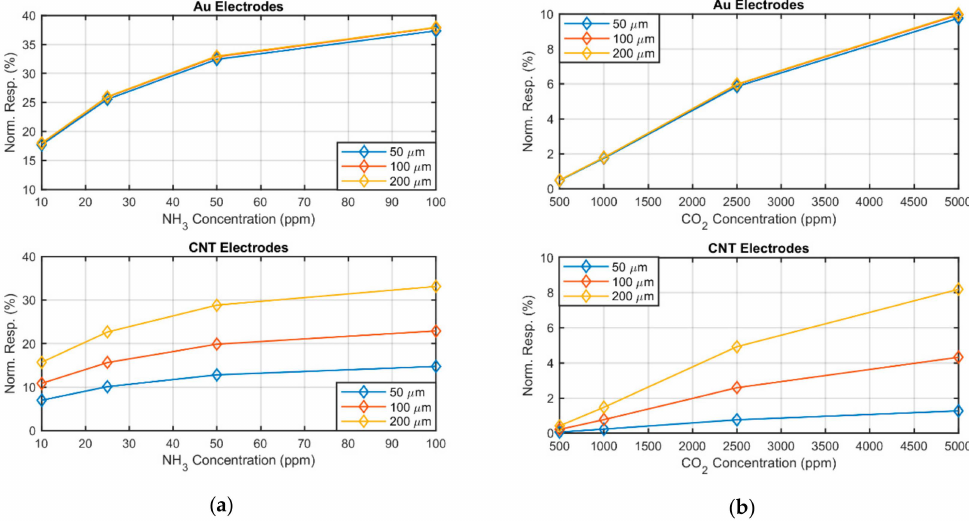
Figure 4. ( a ) Calculated normalized resistance change to NH 3 and ( b ) calculated normalized resistance change to CO 2 for sensors fabricated with Au electrodes ( top ) and CNT electrodes ( bottom ). The discrepancy in response is directly related to the non-negligible electrode resistances, which are 20 Ω for the Au and circa 5.5 k Ω for